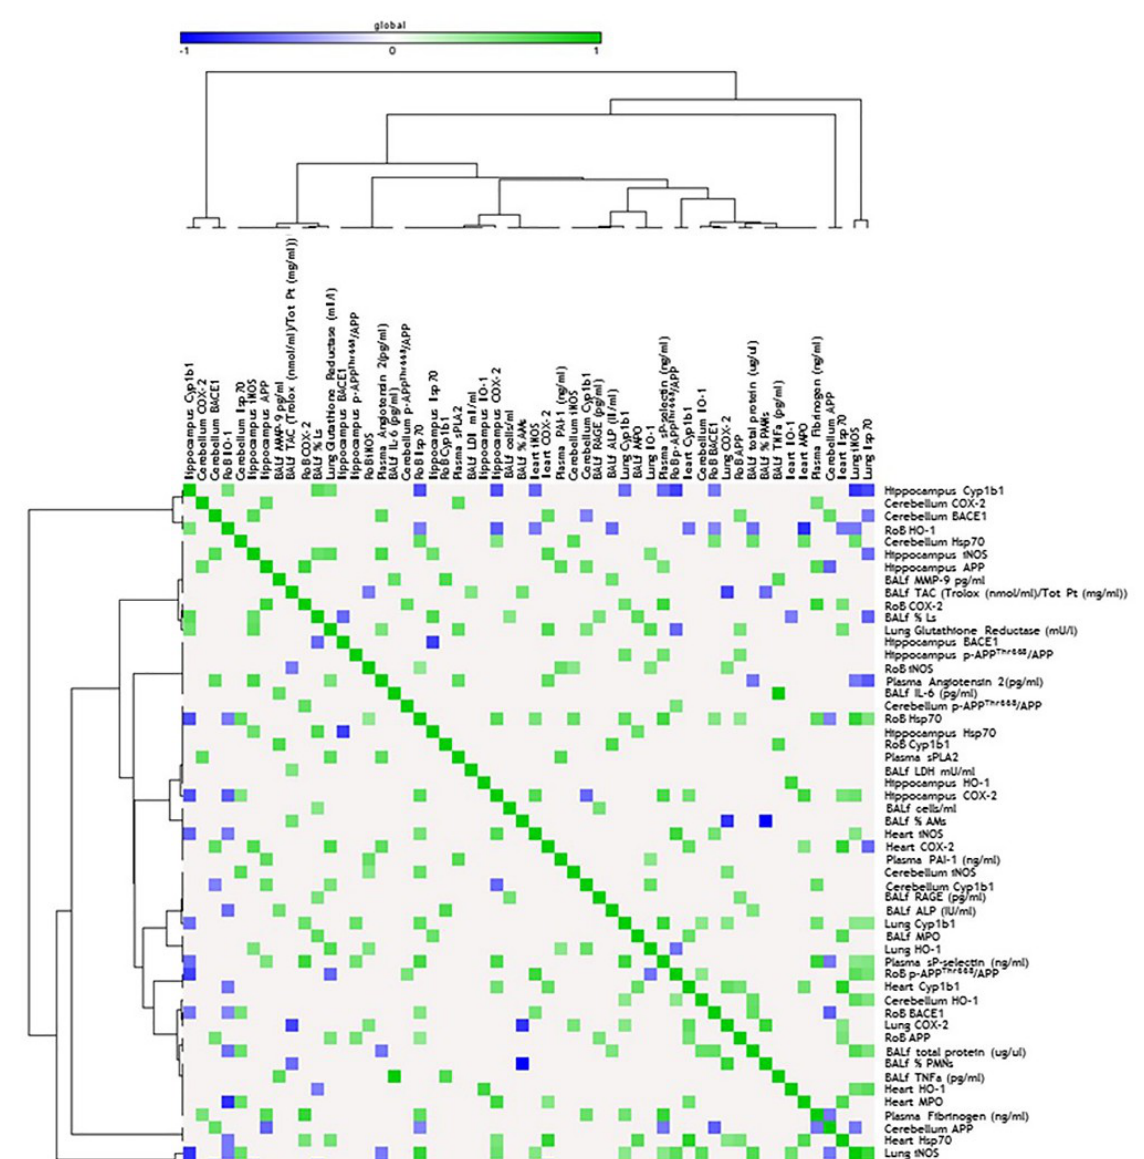
Figure 5. Correlation analysis in sub-acute treatment. Heat map showing the Pearson correlation between markers expressed in the RoB, cerebellum, hippocampus, and respiratory and cardiovascular system markers assessed in the same animals and presented in our previous work [33], after repeated instillation with 50 µ g of BB or DEP / 100 µ L 0.9% NaCl. All the correlation data are reported in Table S1 (Supplementary Materials).